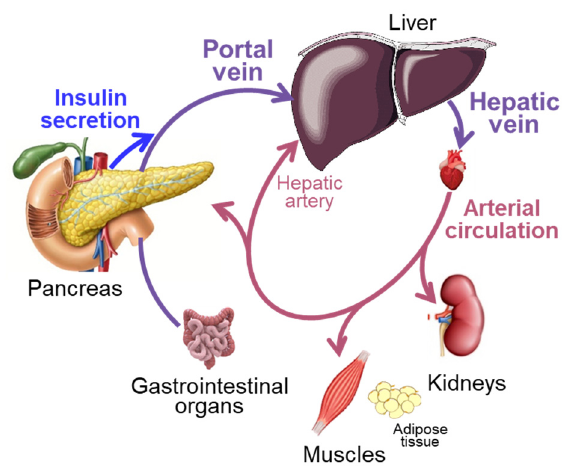
Figure 1. Insulin appearance in and removal from the circulation. Insulin is produced by pancreatic β cells and secreted into the portal vein, which delivers the newly produced insulin to the liver. The liver extracts approximately half of the newly secreted insulin. The remaining insulin is delivered to the systemic arterial circulation via the hepatic veins. Extrahepatic tissues extract some of the insulin from the arterial circulation during the first pass; the remaining insulin is removed in subsequent passes through the liver and extrahepatic tissues. Organ sizes in the figure are depicted according to their importance in determining plasma insulin concentration, rather than proportional to their actual size.